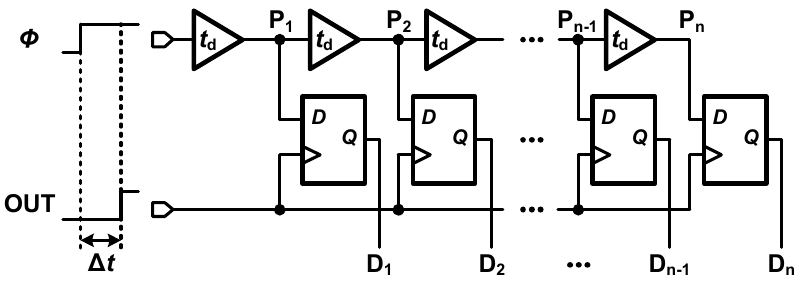
Figure 6. The circuit scheme of the time-to-digital